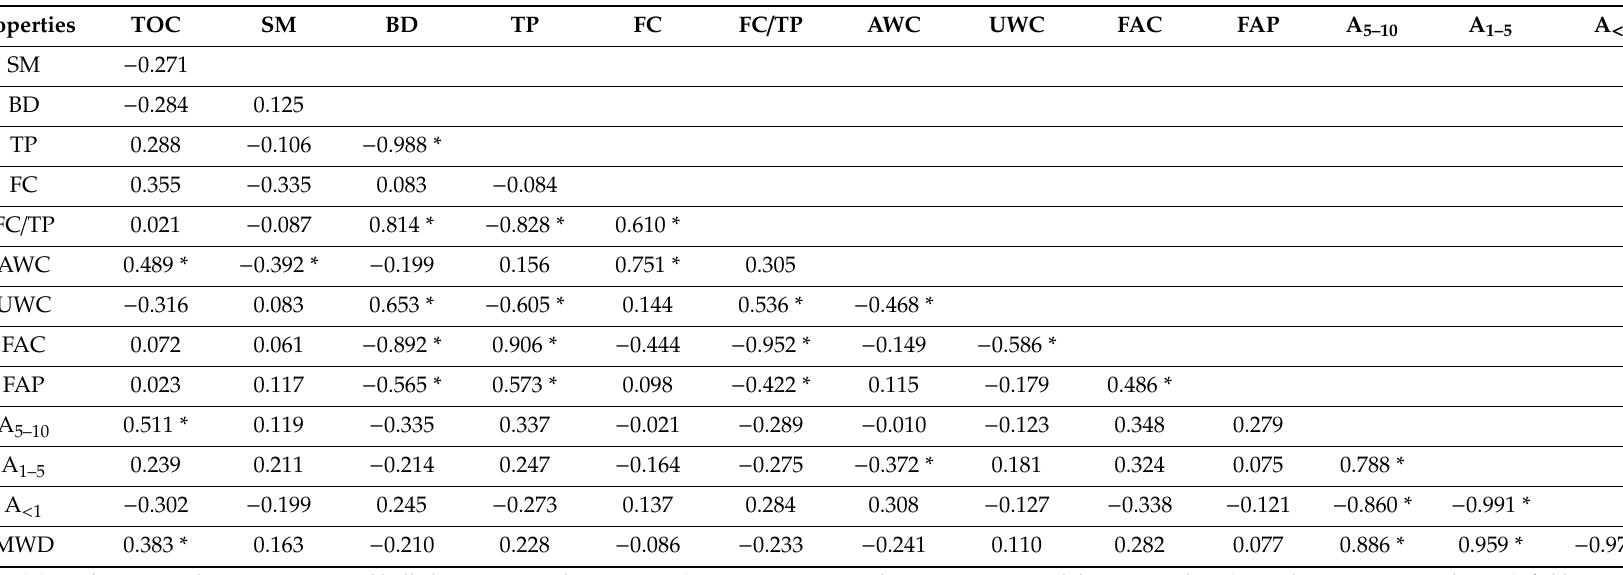
Table 3. The correlation coe ffi cient values for the investigated soil properties (significance value | r | >